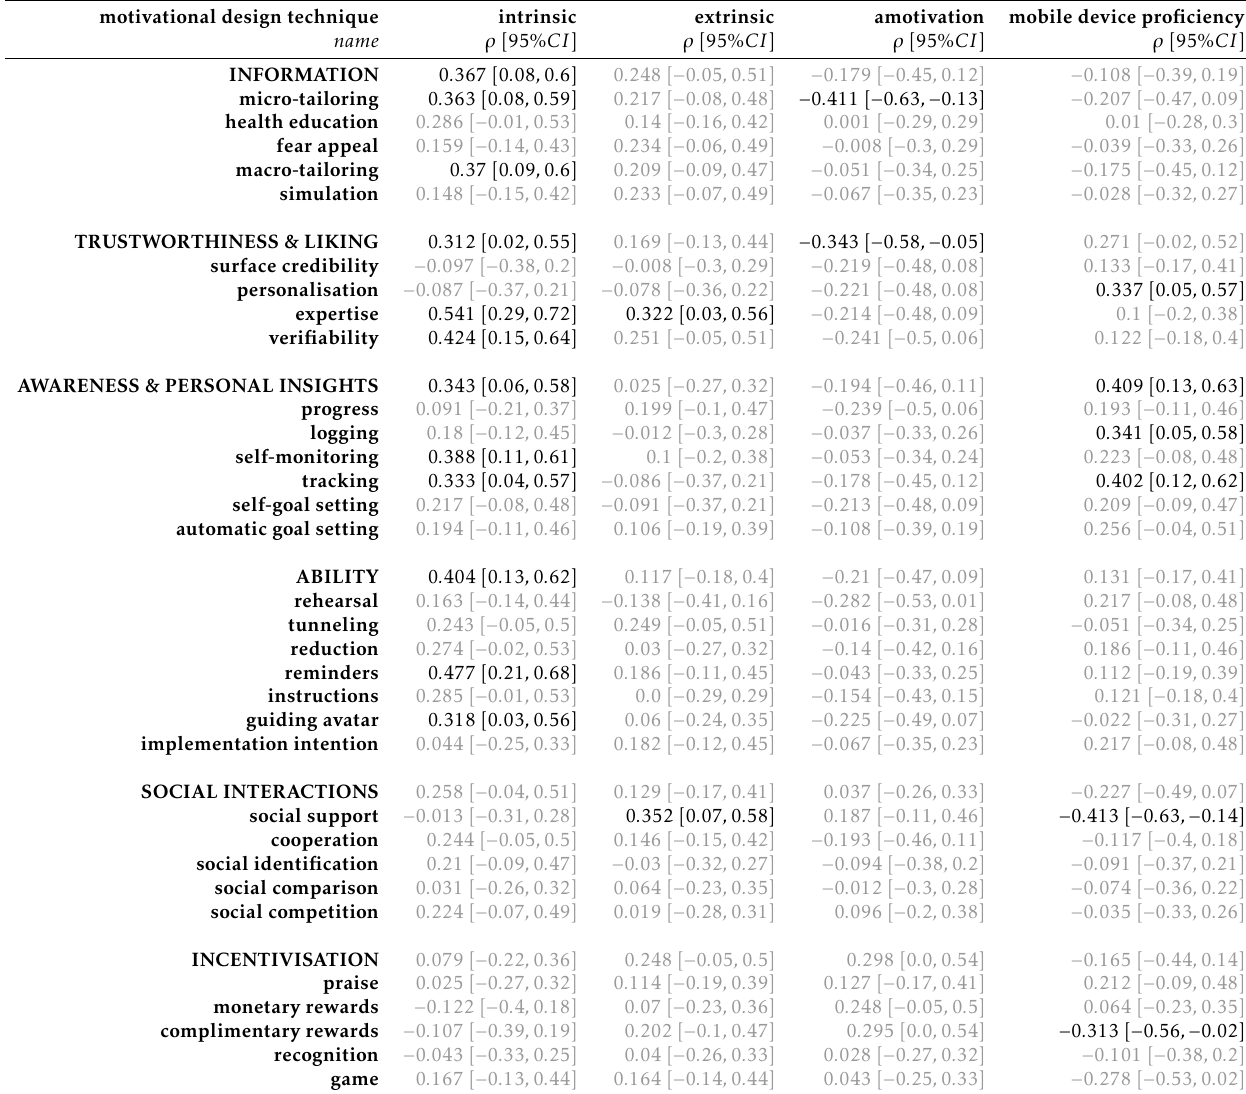
Table 5. Spearman correlations between results on motivation for health management, mobile device proficiency, and motivational design